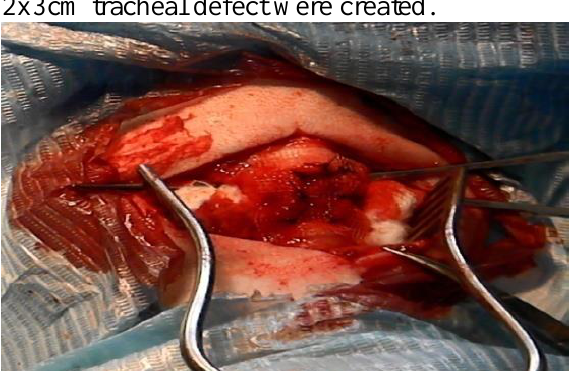
Figure, 2: Shows applied polypropylene mesh on tracheal defect of dog.